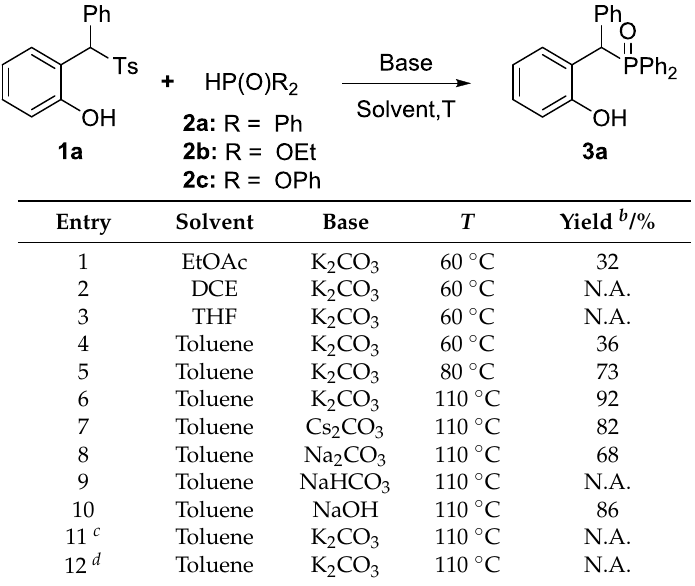
Table 1. Optimization for the reaction of 2-(phenyl(tosyl)methyl)-phenol 1a with secondary phosphine oxide a .